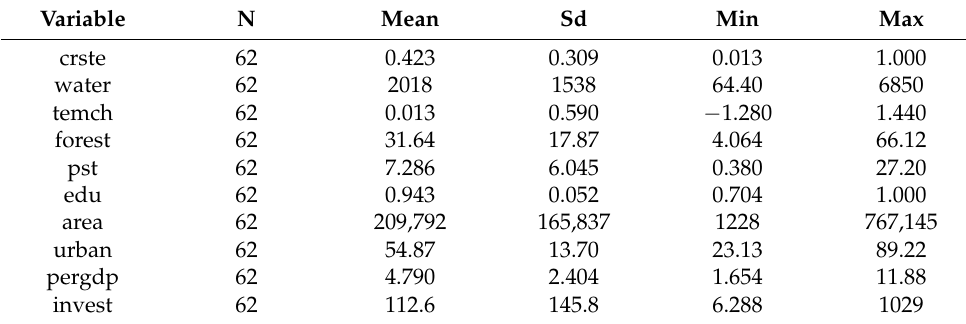
Table 4. Statistical description of variables.